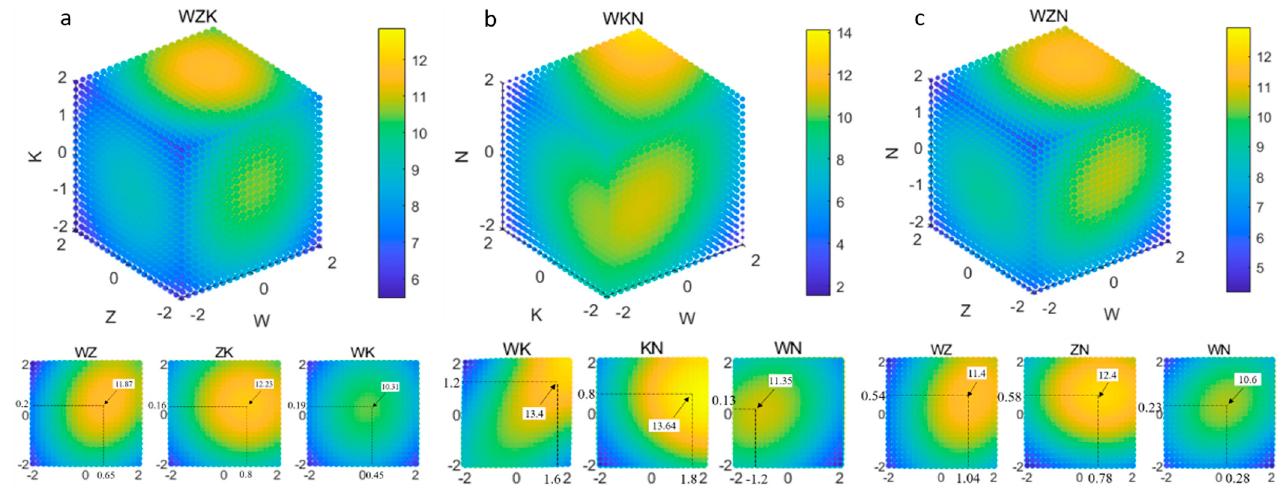
Figure 4. Combined effects of trios of factors (( a ): W × Zn × K , ( b ): W × K × N , ( c ): W × Zn × N ) on net photosynthetic rate ( Pn ).